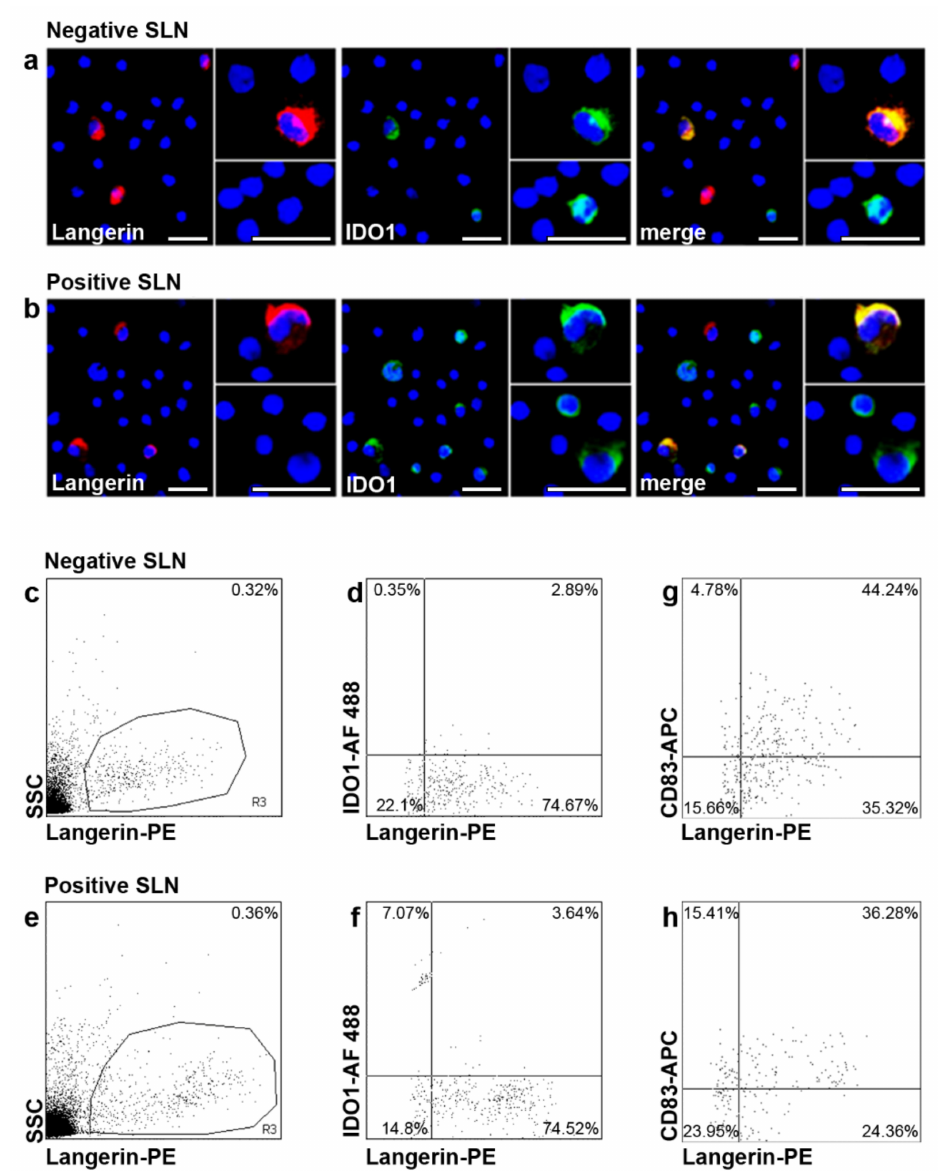
Figure 2. Fluorescent immunocytochemistry and flow cytometry analyses of IDO1 in SLN LCs. ( a , b ) Double fluorescent immunocytochemistry analyses were performed on cytospins of negative and positive SLNs ( n = 10 negative and n = 4 positive SLNs from n = 12 patients) with the indicated Abs and fluorescences (anti-Langerin, red; anti-IDO1, green); co-expression of both molecules (yellow- orange) is indicated as “merge”. Nuclei were labelled with Hoechst (blue). Original magnification × 200 and × 400 in the inset; scale bars = 20 µ m and 40 µ m, respectively. Details from representative images from negative and positive SLN are shown. Only a fraction of Langerin + LCs expressed IDO1 ( a , b ). Langerin-IDO1 + cells were also observed, characterized by different sizes, especially in